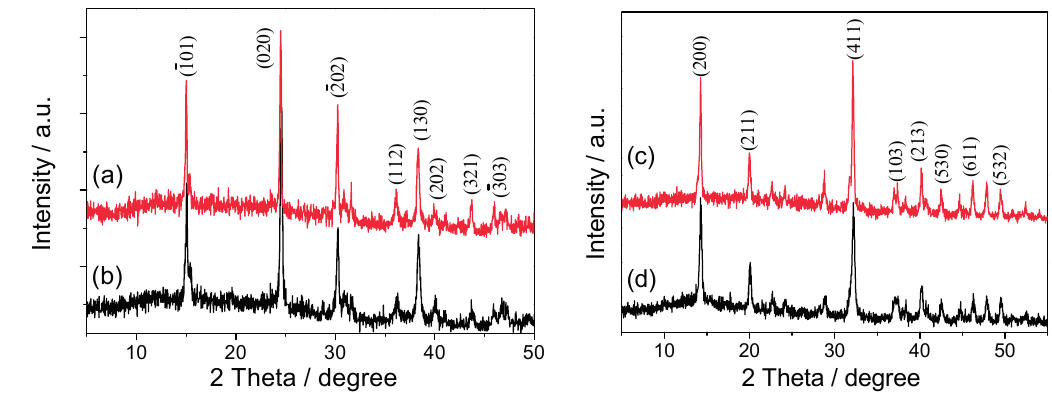
Figure 5. XRD patterns of the synthesized nano COM and nano COD crystals and the crystals in presence of 0.20 mg/L HP, respectively. (a,b) COM; (c,d) COD. c (HP): (a,c) the synthesized crystals; (b,d) the crystals in presence of 0.20 mg/L HP. Incubation time: 24